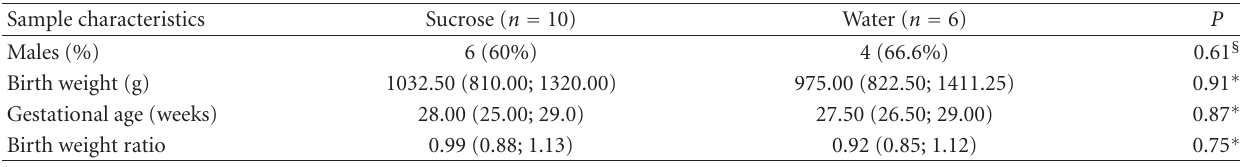
Table 1: Study participants’ baseline characteristics according to the solution